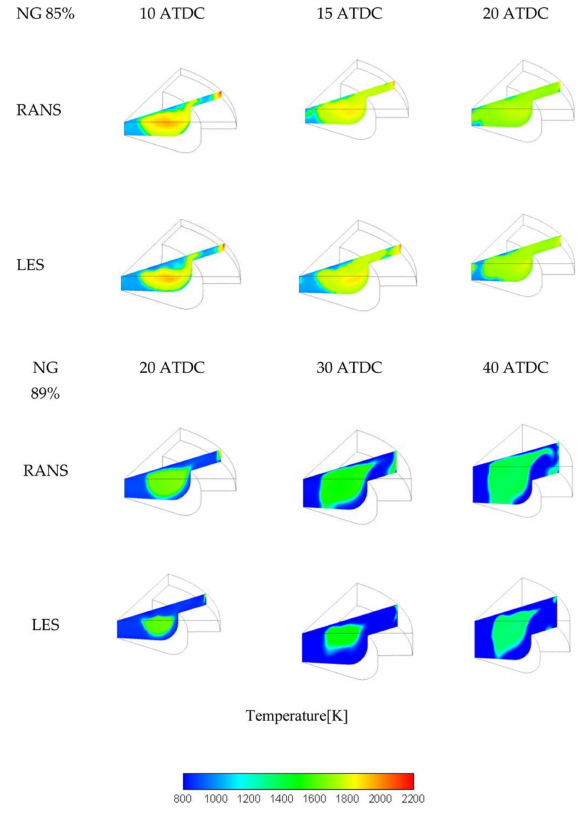
Figure 6. Comparison of LES and RANS model for cylinder temperature cut planes at three crank angles for different natural gas